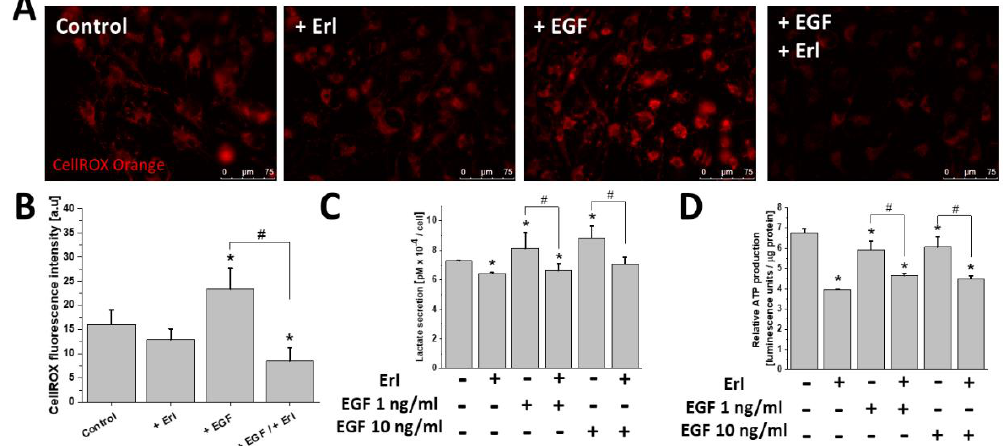
Figure 3. Effect of EGF on cellular redox and bioenergetic status modulation. ( A-B ) EGF (10 ng/mL) promoted mitochondrial (mt) ROS production. Measurements were performed with CellROX Orange reagent. ( C-D ) EGF noticeably affected the efficiency of lactate/ATP biosynthesis in GBM cells. Note that all of the abovementioned phenomena were attenuated by EGFR inhibition with erlotinib. Bars represent S.E.M, n = 40 cells. Statistical significance was calculated with non-parametric Mann–Whitney test, * p < 0.05 vs. control; # p < 0.05 vs. reference condition. Scale bars = 75 µ